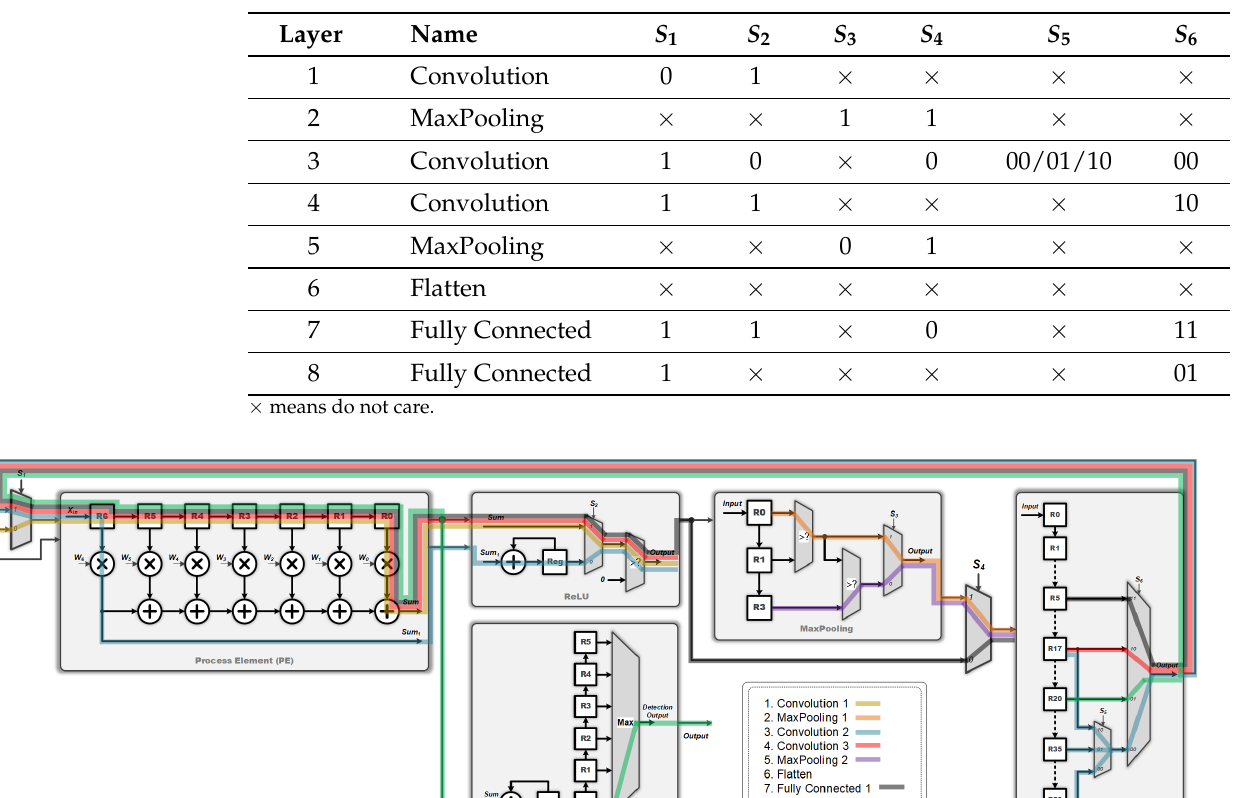
Figure 8. The operation for each layer in the proposed circuit.